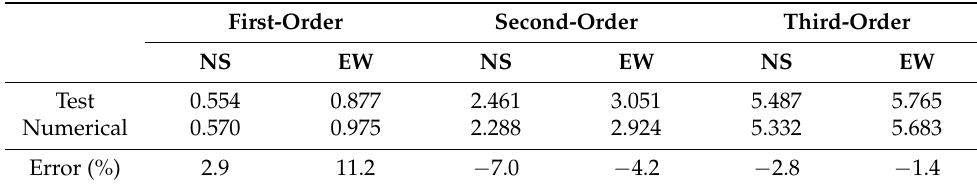
Table 2. The first three-order frequencies of the test and numerical results (Unit: Hz).